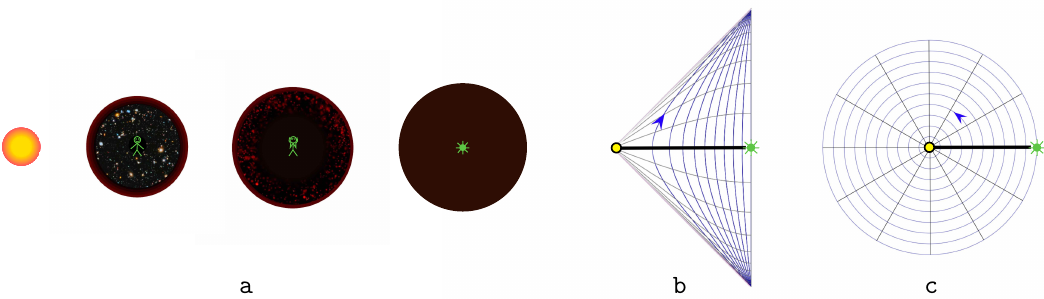
Figure 1 . a: cartoon of observable universe evolving to its maximal-entropy equilibrium state. The horizon consumes everything once seen, growing until it reaches its de Sitter equilibrium area A . (The spiky dot is a reference point for b , c ; it will ultimately be gone, too.) b: Penrose diagram of dS static patch. c: Wick-rotated ( b ) = sphere. Metric details are given in appendix D.3 + figure 14 c,d